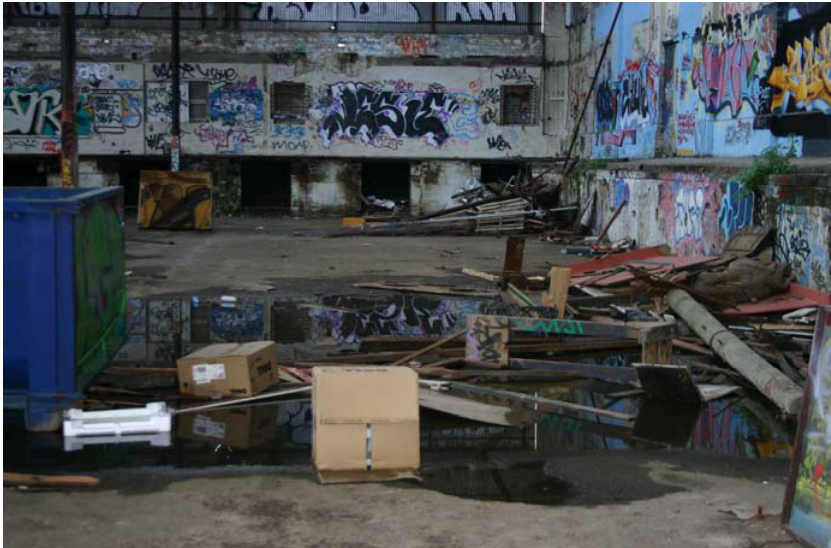
Figure 4. Rozelle Tram Depot (Glebe, 2008).